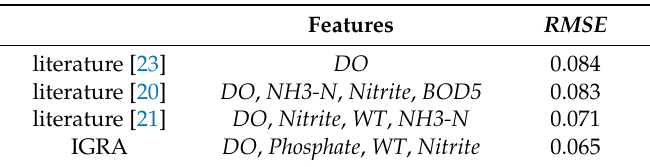
Table 4. Feature selection and prediction error of Victoria Bay.